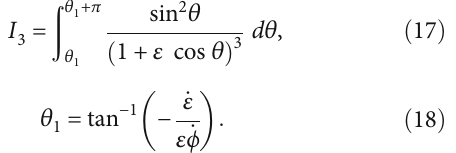
ω ω − ω ω + ω 1 ; (b) 2 ; (c) 1 2 ; (d) 1 2 .